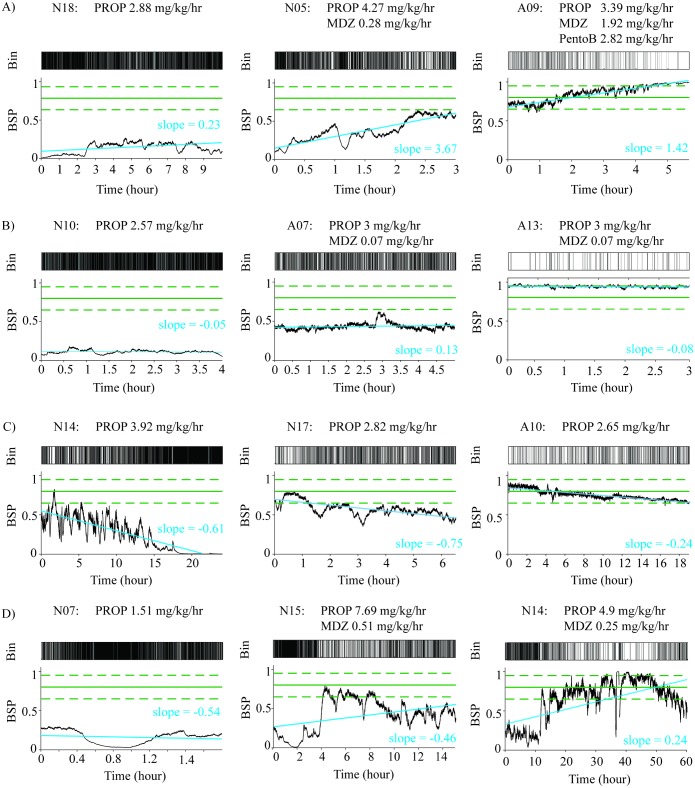
Example BSPs from 12 patients demonstrate the large degree of intra-patient variability in BSP achieved maintained on constant doses of IVADs.Solid green lines indicate the reference of BSP 0.8 and the dashed green lines indicate the reference range 0.65–0.95. The blue line shown is the linear regression line for the BSP data. A) Increasing BSP over time. B) Approximately constant BSP over time. C) Decreasing BSP over time D) Varying up and down over time. For each panel A–D), we deliberately chose examples with low, median and high median BSP values to show that the trends are not unique to BSP ranges.